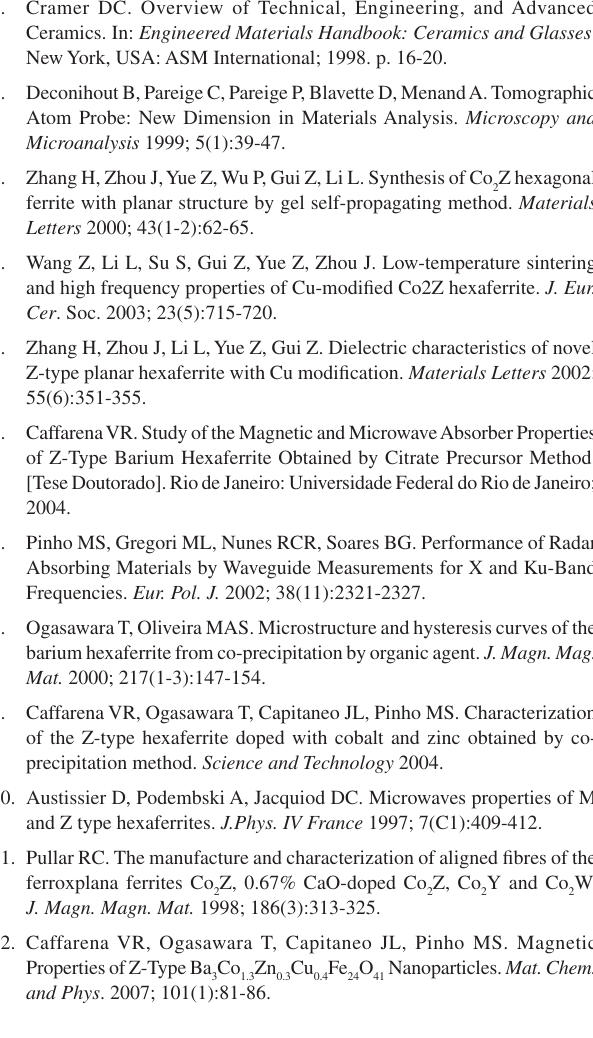
Figure 10. Scanning electron micrograph of Ba polychloroprene (80:20, wt. (%)) used to perform the microwave absorber measurements. Magnification =